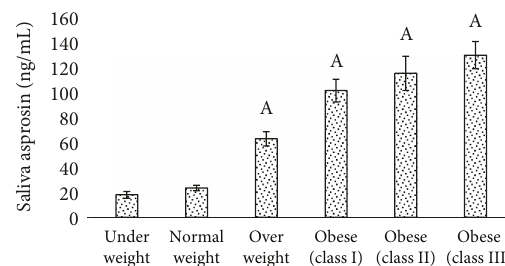
Figure 2: Comparison of salivary asprosin values of underweight, normal weight, and overweight individuals and participants with classes I, II, and III obesity. a Normal weight versus another group ( p < 0 005